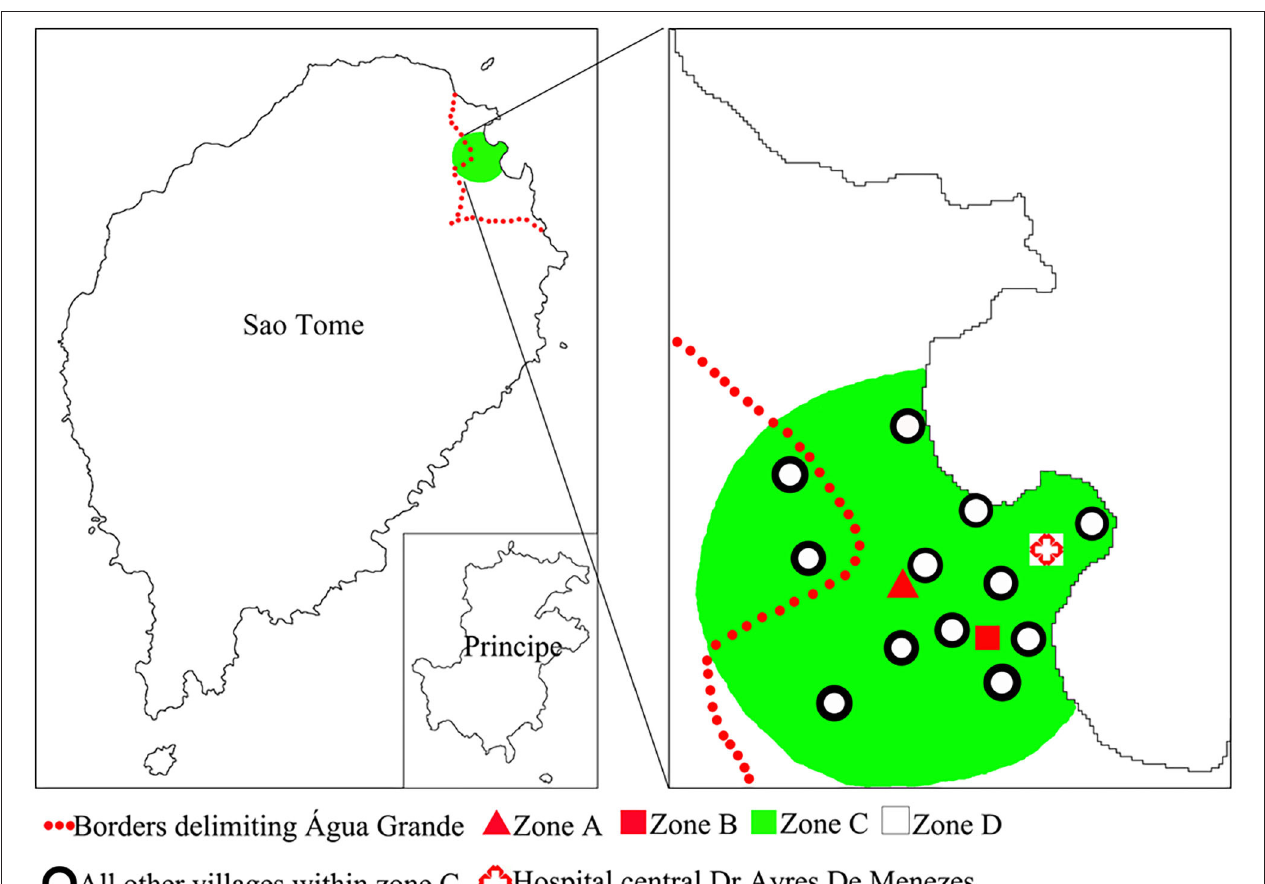
FIGURE 2 | Distribution of AP-MDA village and its